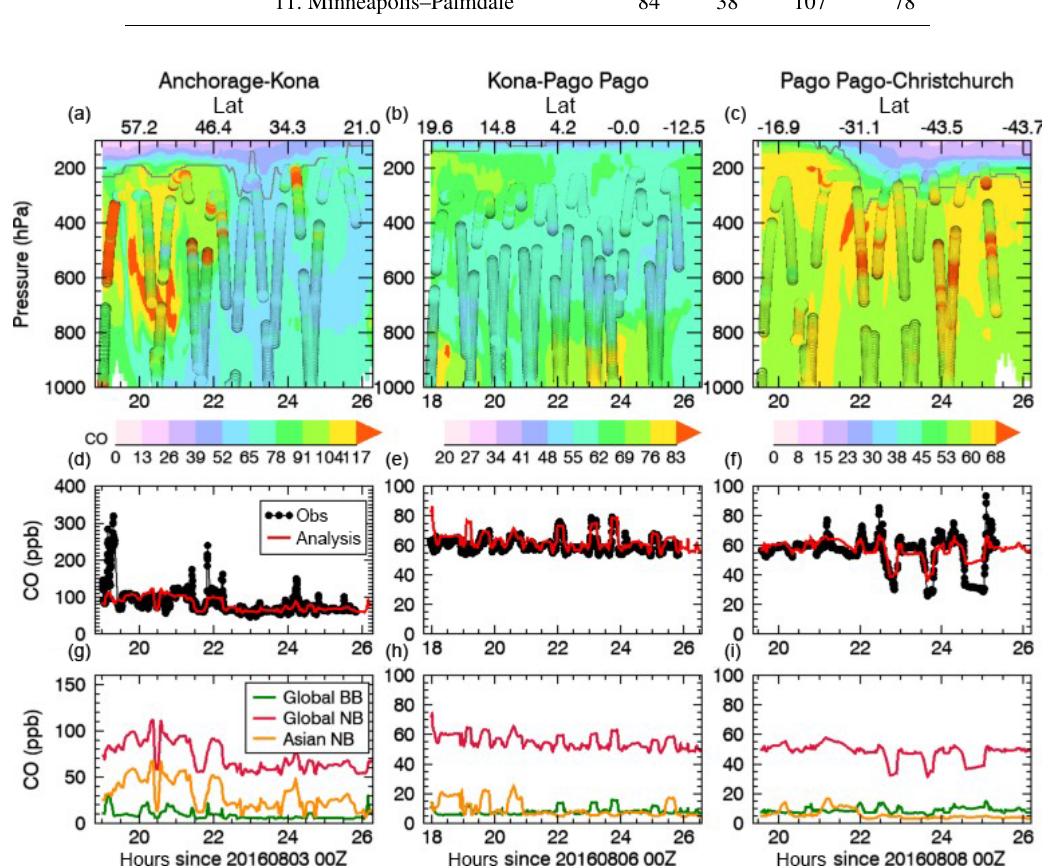
Figure 1. Curtain plot of CO (ppb) from the GEOS-5 analysis as a function of time and pressure overplotted with the model tropopause (gray line) and QCLS CO observations (circles) (a, b, c) for the (a) Anchorage–Kona flight, (b) Kona–Pago Pago flight, and (c) Pago Pago– Christchurch flight. Axis ranges vary between panels due to the large range of concentrations encountered. The top x axis indicates the latitudes of the flight track. (d–f) The GEOS-5 CO interpolated to the flight track (red line) is compared to the observations (black circles). (g–h) Tagged tracer contributions to the GEOS-5